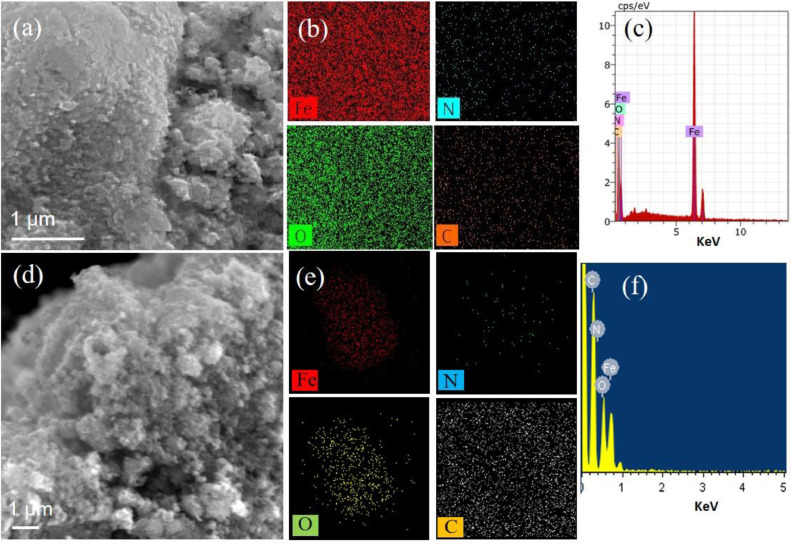
(a and d) FE-SEM micrographs, (b and e) EDS mapping, and (c and f) EDAX spectrum for Fe2O3 prepared at 350 °C and 450 °C, respectively.